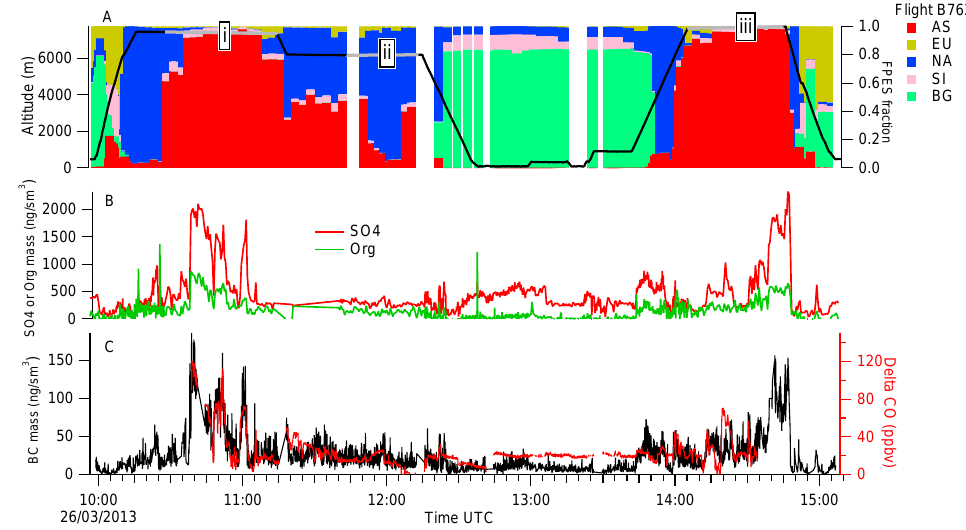
Figure 4. (a) The flight altitude and FLEXPART FPES fractions for each source region during B763, the plume locations during SLR are marked as i, ii and iii and grey lines along the flight altitude track; (b) the time series of organic matter and sulphate; (c) BC mass and CO